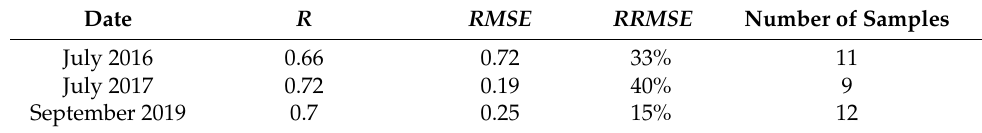
Table 5. Verification of stepwise regression method for determination of chlorophyll-a concentration based on Landsat-8 OLI in the Guanting Reservoir. The R , RMSE , and RRMSE between the retrieval value from the stepwise regression model and the measurements from samples.